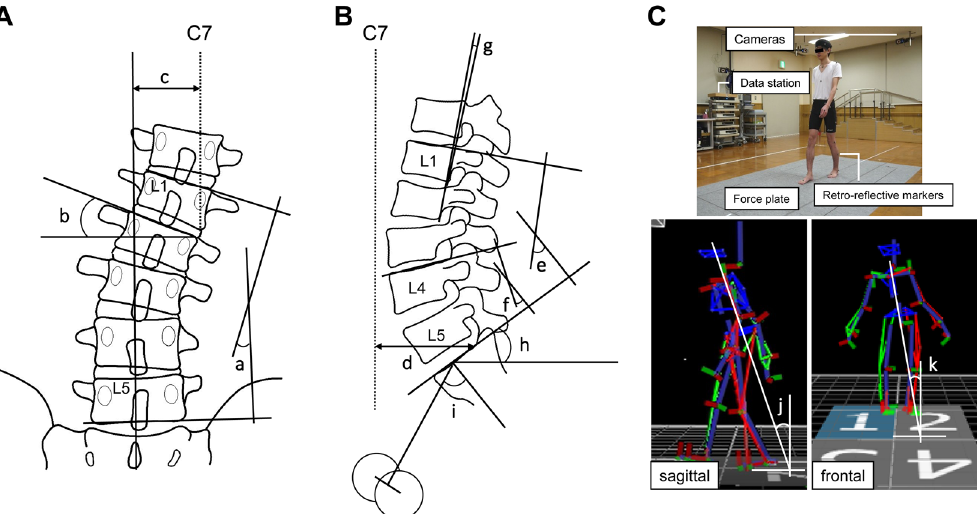
Figure 5. Radiological measurements and gait analysis. ( A ) Lumbar coronal plain radiographs: (a) Cobb angle (L1–L5), (b) L2 wedge angle, (c) coronal decompensation using the C7-central sacrum vertical line (CSVL). ( B ) Lumbar lateral plain radiographs: (d) C7-sagittal vertical axis (SVA), (e) lumbar lordosis (LL) (L1–S1), (f) L4–S1 angle, (g) L1–L2 local lordotic angle, (h) sacral slope, (i) pelvic incidence (PI). ( C) Gait analysis using a 3D motion analysis system. Walking speed and step length were assessed as spatiotemporal parameters. Sagittal and coronal tilt (angle of the thorax segment relative to the global coordinate system) were assessed as kinematic